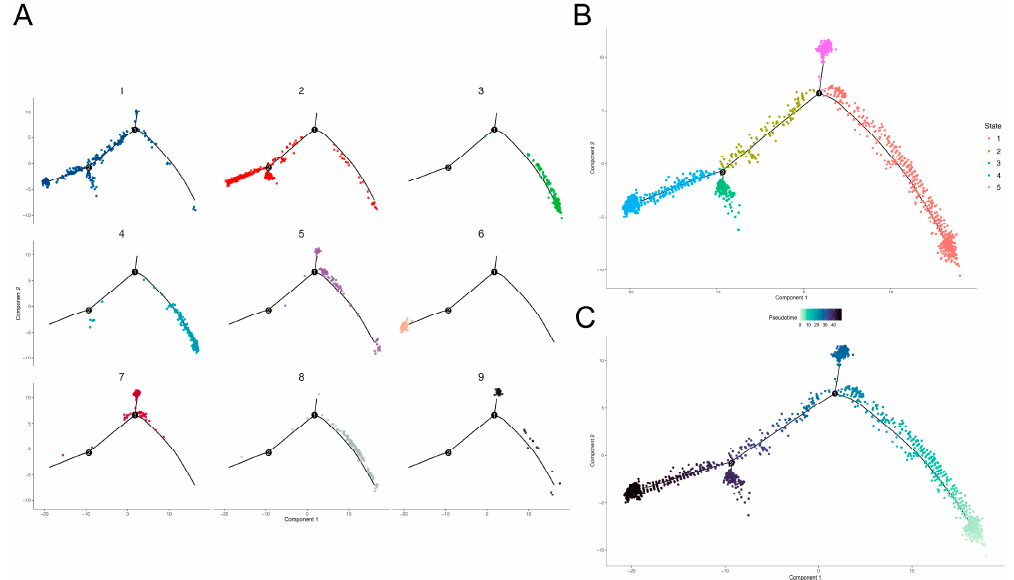
Figure 4. Developmental trajectory of pediatric GBM cells. The X-axis and Y-axis are two dimensions, the black lines represent the fitted development trajectories and the solid black circles represent branch points. ( A ) Faceted figure of cell clusters. Cell clusters are distinguished by different colors, corresponding to the previous clustering results, and the distribution of each cell cluster in the trajectory is drawn separately. ( B ) Time state of cells. Time states are distinguished by different colors. ( C ) Pseudotime value. The pseudotime value reflects the development direction of trajectory and is rep-